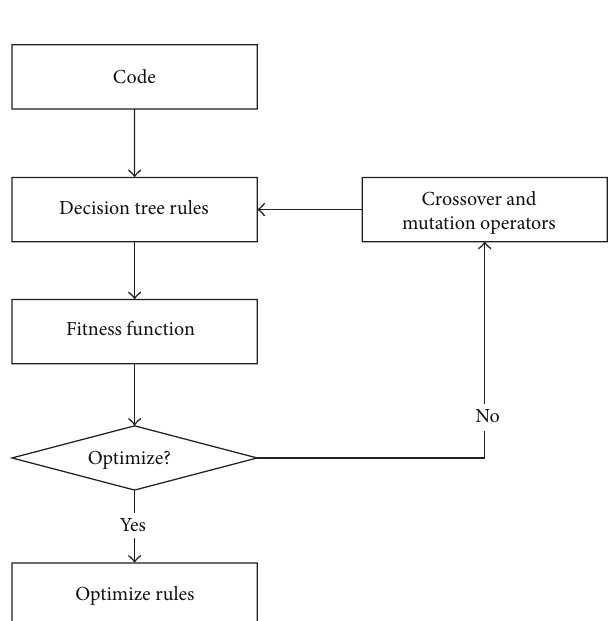
Figure 3: Processes of